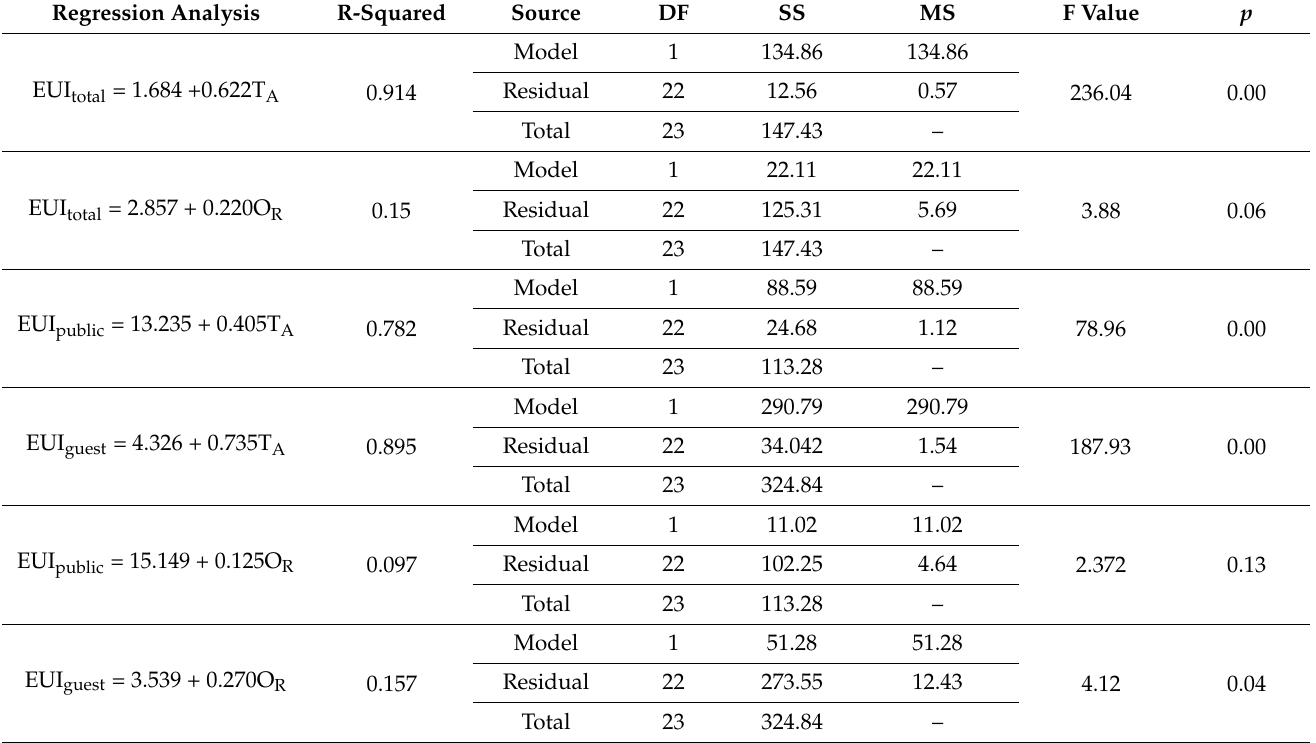
Table 3. Regression analysis